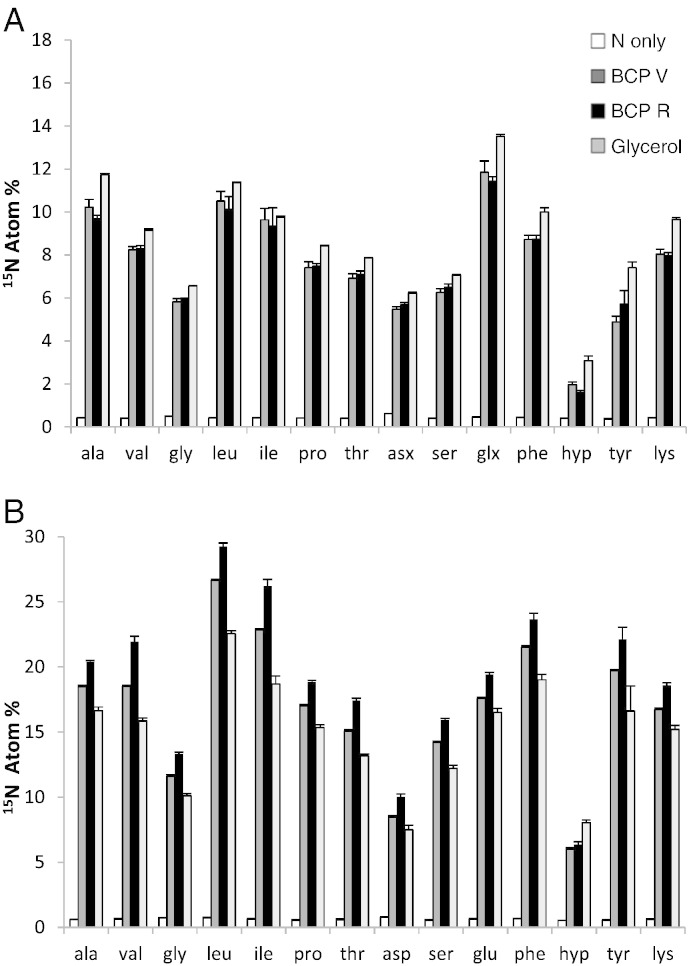
A: 15N incorporation into total hydrolysable amino acids (THAAs); l.s.d.α = 0.0515N treatment effect = 0.23%.B: 15N incorporation into EPS amino acids (EPS-AAs); l.s.d.α = 0.0515N treatment effect = 0.43%.